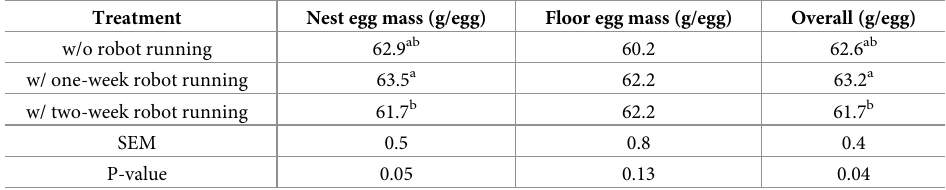
different superscripts are significantly different, with a significance level of 0.05, least square difference post-hoc analysis, and PROC MIXED statement. ‘w/’ and ‘w/o’ represent with and without,